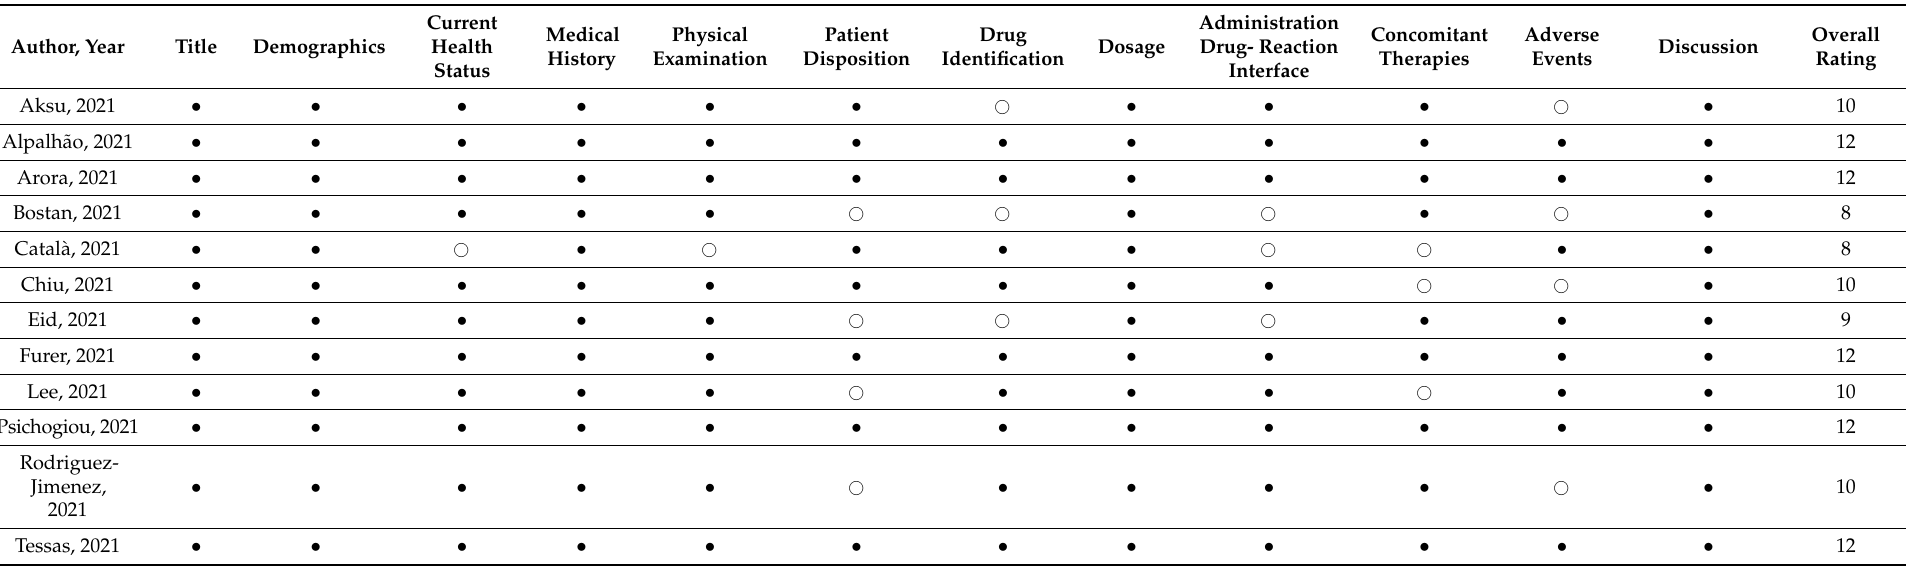
Table 3. Quality assessment of the included